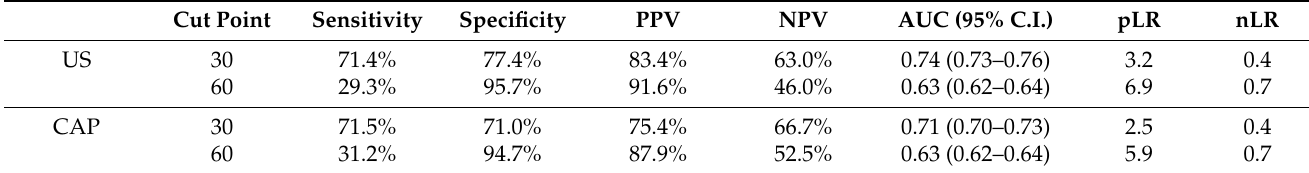
Table 2. Comparison of AUCs of fatty liver index for predicting nonalcoholic fatty liver disease.